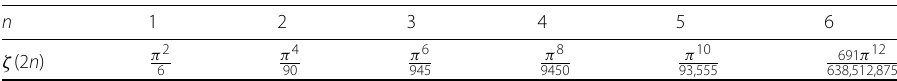
Table 1 Values of ζ (2 n